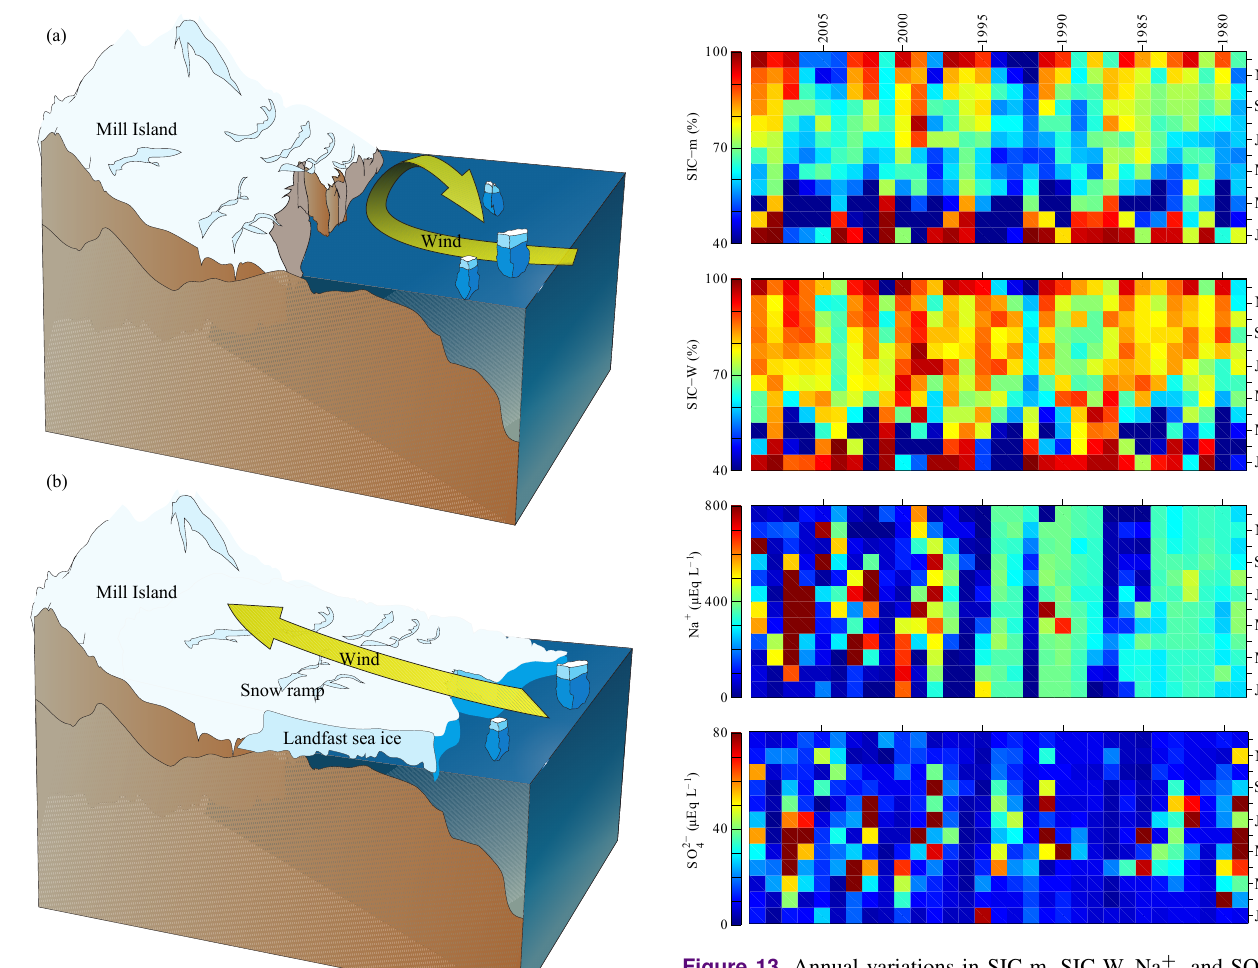
Figure 13. Annual variations in SIC-m, SIC-W, Na + , and SO 2 over the period from 1979 to 2009. The x axis is year, y axis is month, and the colour shows sea-ice/trace ion concentration. Each pixel shows the monthly mean concentration of associated species. Chemical data were interpolated to 12 data points per year. No other filtering was